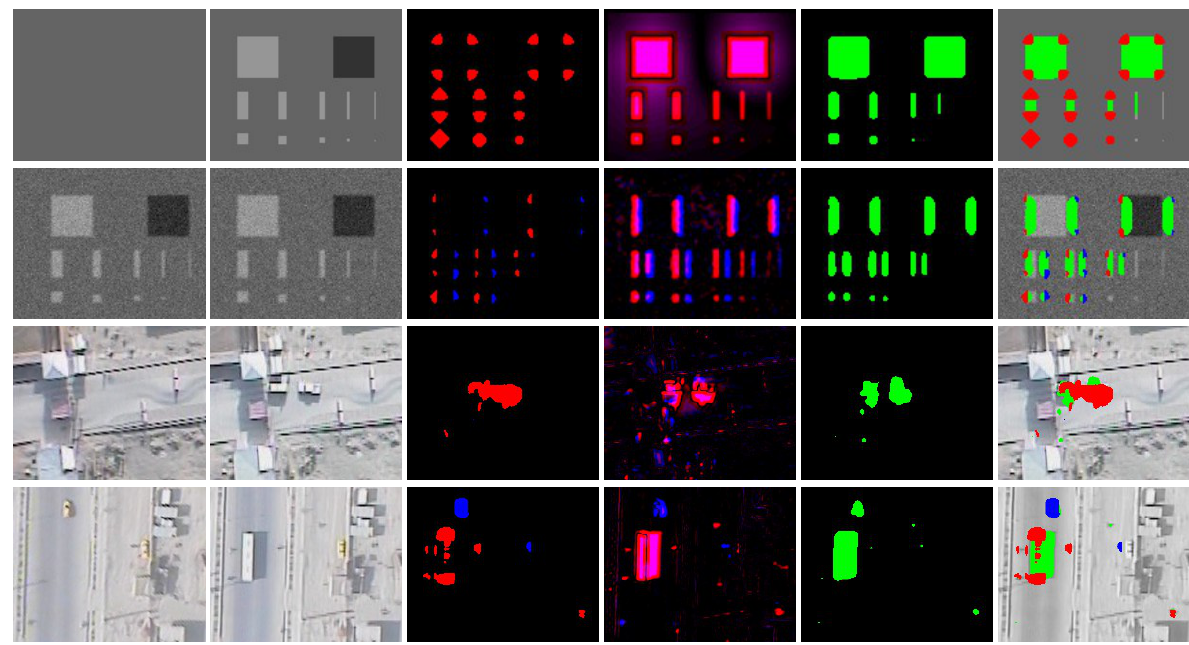
Figure 2: Change detection examples (1st-4th row): Previous image (1st column), current image (2nd column), masks of feature based approach (3rd), extended image differences using a 7 (cid:2) 7 neighborhood (4th), differencing mask (5th), and combined mask over current gray image (6th column). 1st row: Constant gray image and synthetic test image containing rectangles and squares of width 1, 2, 4, 6, and 8 pixels. 2nd row: Two copies of the test image with added noise and left-shifted by 8 pixels. 3rd and 4th row: subframes of aligned video frames. The colors red and blue in the 3rd, 4th and 6th column correspond to structures present in the current and previous image and indicate new or vanished objects. Magenta in the 4th and green in the 5th and 6th column denote changed object